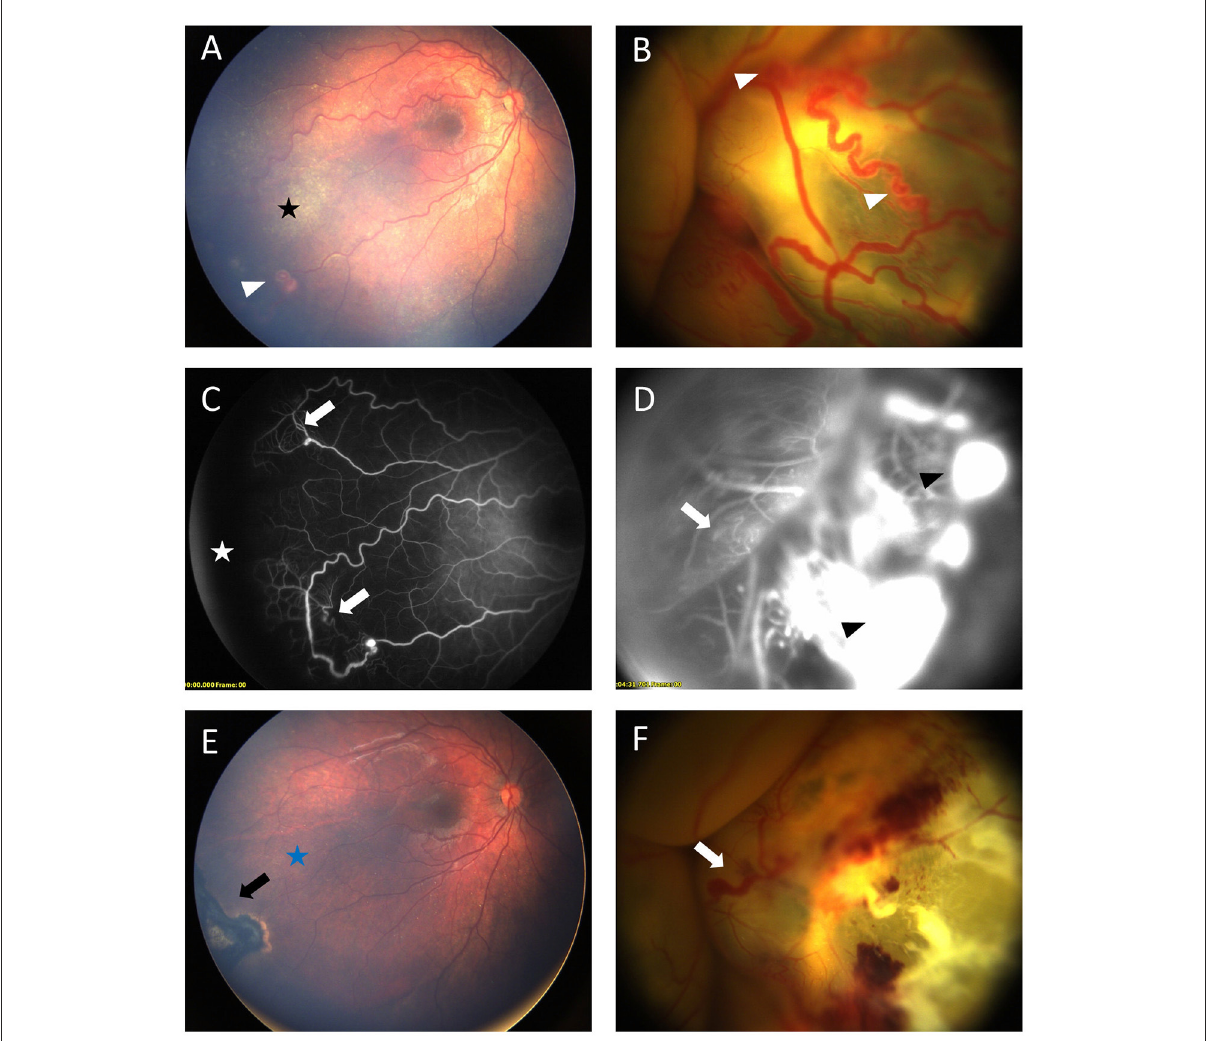
FIGURE2 Bilateral Coats’ disease in a 17-month-old girl. RetCam fundus photograph of the right eye (A) shows a stage 2A with moderate exudates (black star) sparing the fovea and ≪ light bulb ≫ aneurysms (white arrow head). Left eye (B) shows a stage 3B with a total retinal detachment covered with extensive aneurysms (white arrow head). Fluorescein angiography shows capillary dilatation and dropout (white arrows) on both eyes (C) right eye, (D) left eye and a peripheral avascular area (white star) on the right eye. Intense leakage is visible on the left eye (black arrow head). (E,F) shows fundus after first session of laser photocoagulation. On the right eye (E) black arrow shows retinal scar of photocoagulation and complete resolution of exudates (blue star). On the left eye (F) major exudates and dilated capillaries are still present (white